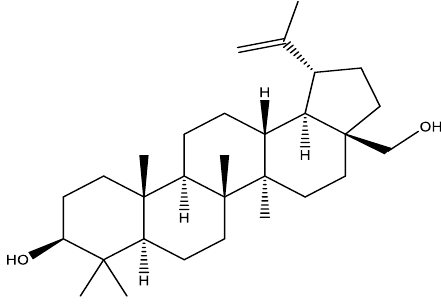
Figure 1. Structure formula of betulin.